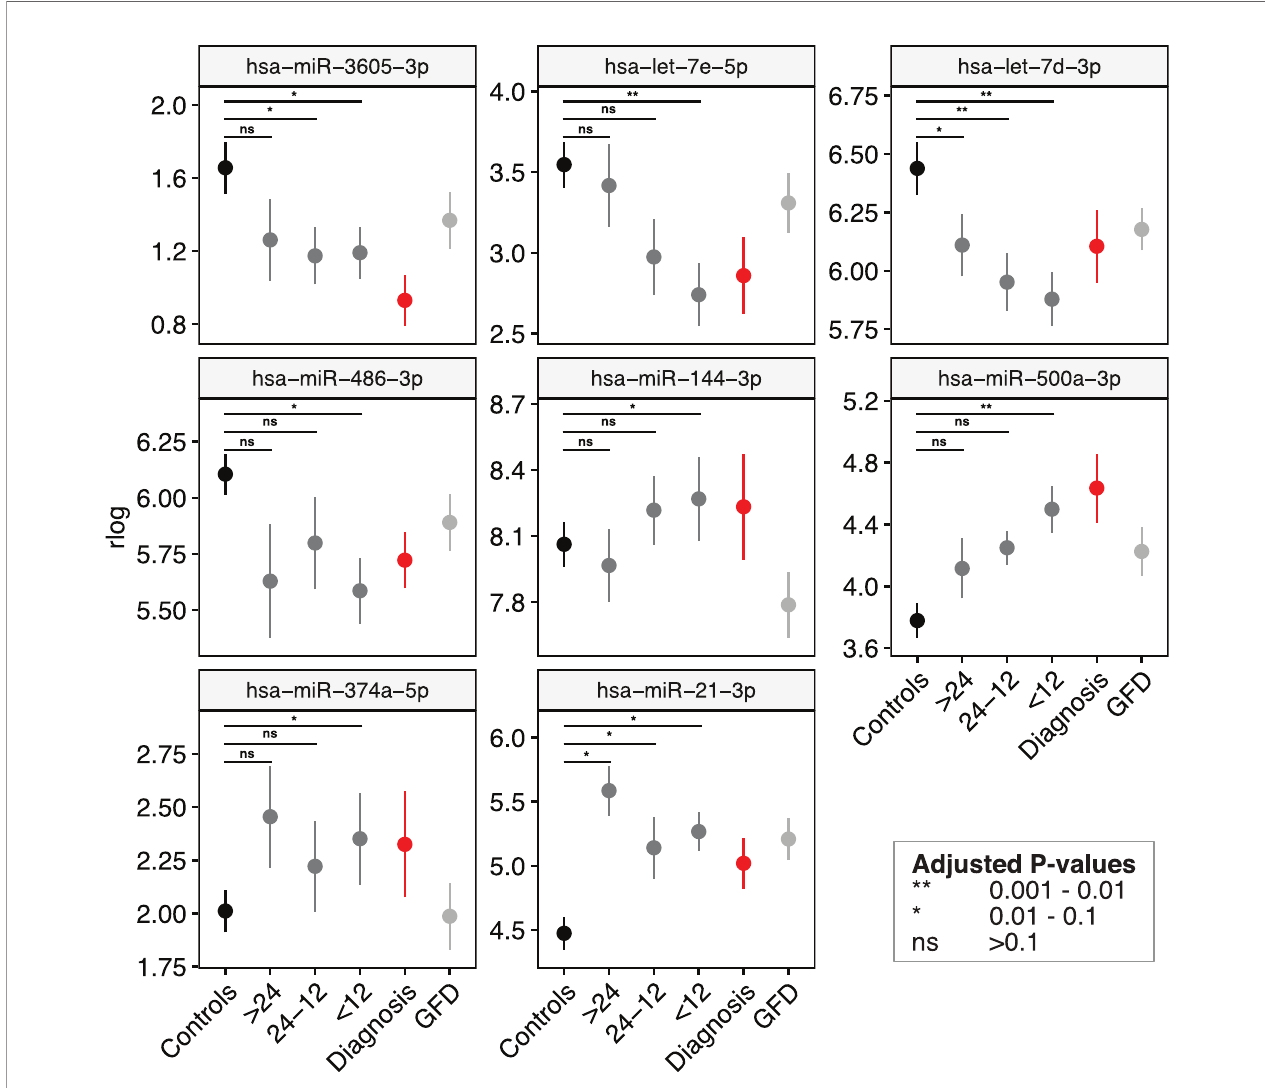
FIGURE 4 | Several miRNA biomarkersfor CeDchange monthsto yearsbefore detection of CeDserology. The levelsof eight out of the53 microRNAs listed in differ from controls< 12 months before seroconversion ( fi rst IgA anti-transglutaminase positivity). Shown are mean values ± standarderror of the regularized log-normalized miRNA counts, corrected for batch and age. Black:controls; Dark-grey: pre-diagnostic samples of CeD patients grouped bymonths till seroconversion (allsamples had negative IgA anti-transglutaminase levels);Red:samples at diagnosis (samples atseroconversion or at time of biopsy); grey: CeD patients after start of the